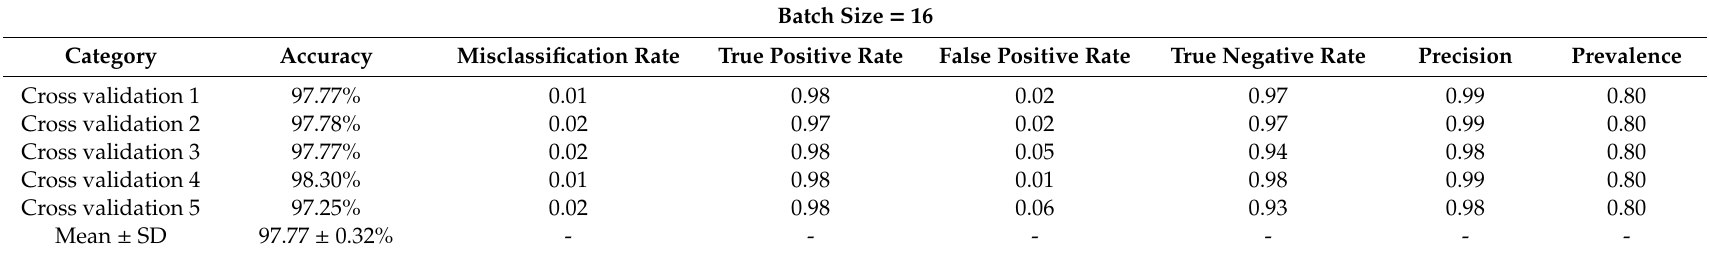
Table 2. Accuracy, misclassification rate, true positive rate, false positive rate, true negative rate, precision, prevalence, and mean and standard deviation of accuracy for a batch size of